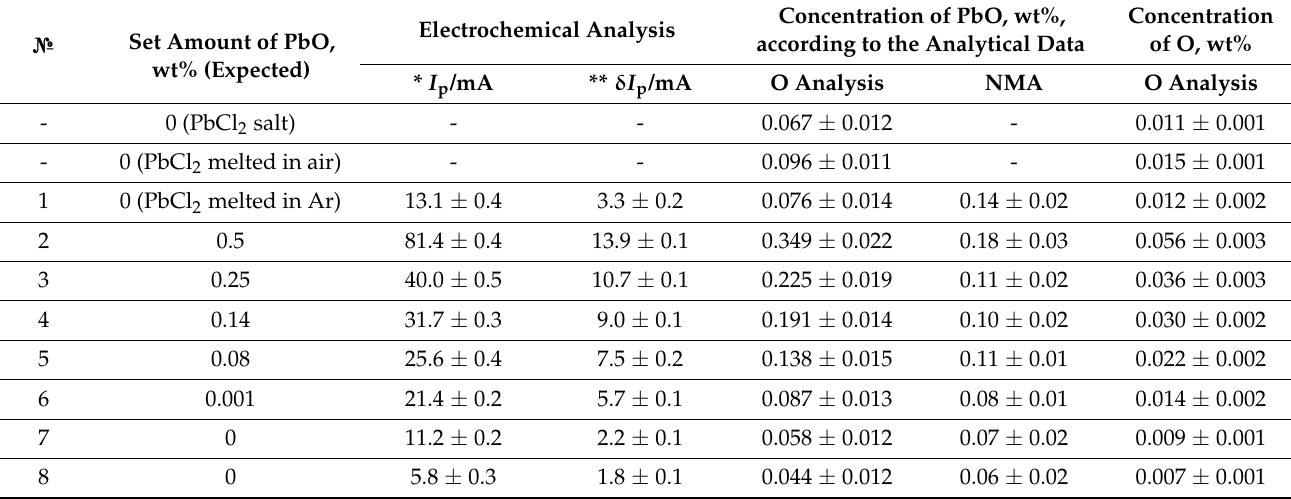
Table 1. Results of oxygen analysis in the PbCl 2 -PbO melt .